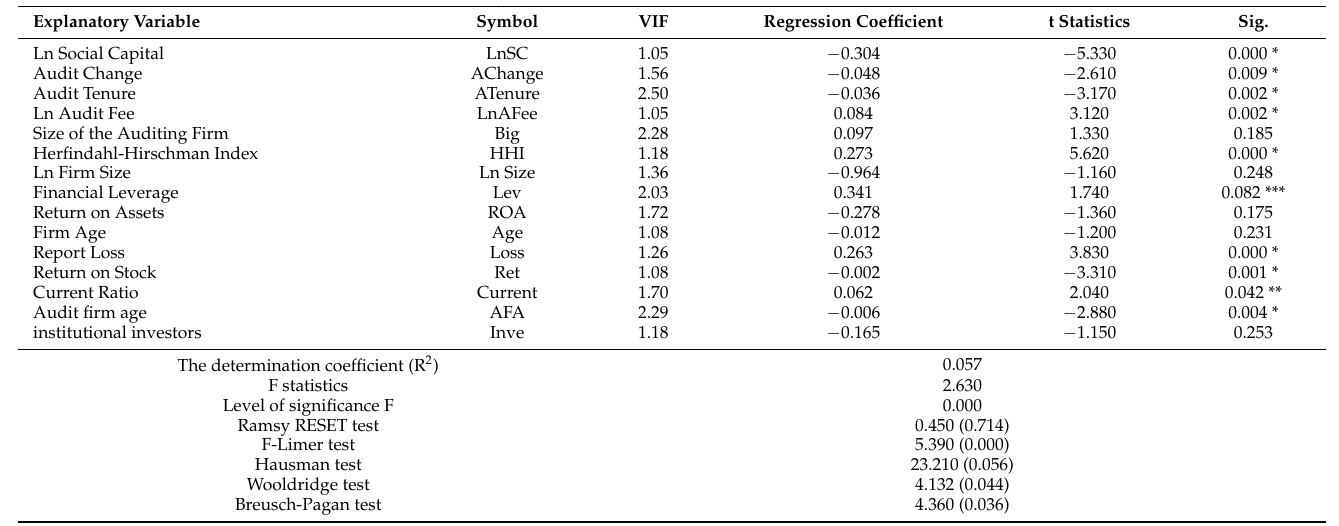
Table 3. The Results of testing the first